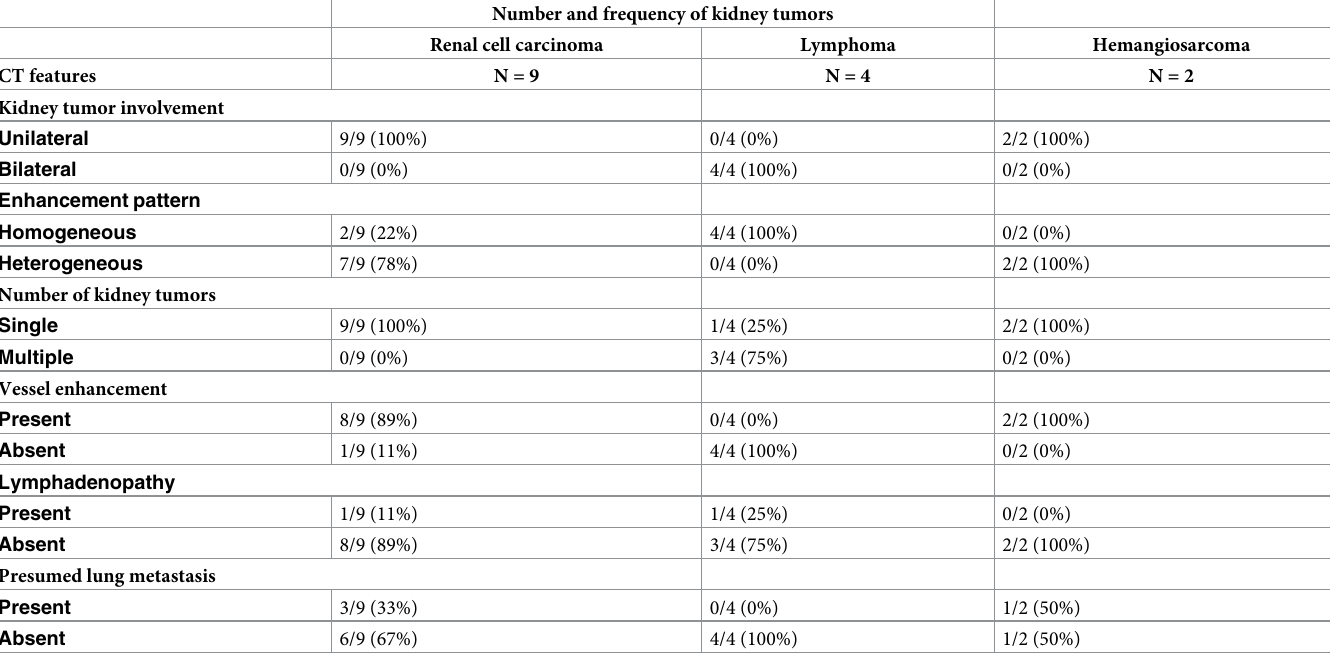
Table 1. Computed tomography (CT) features of each renal tumor